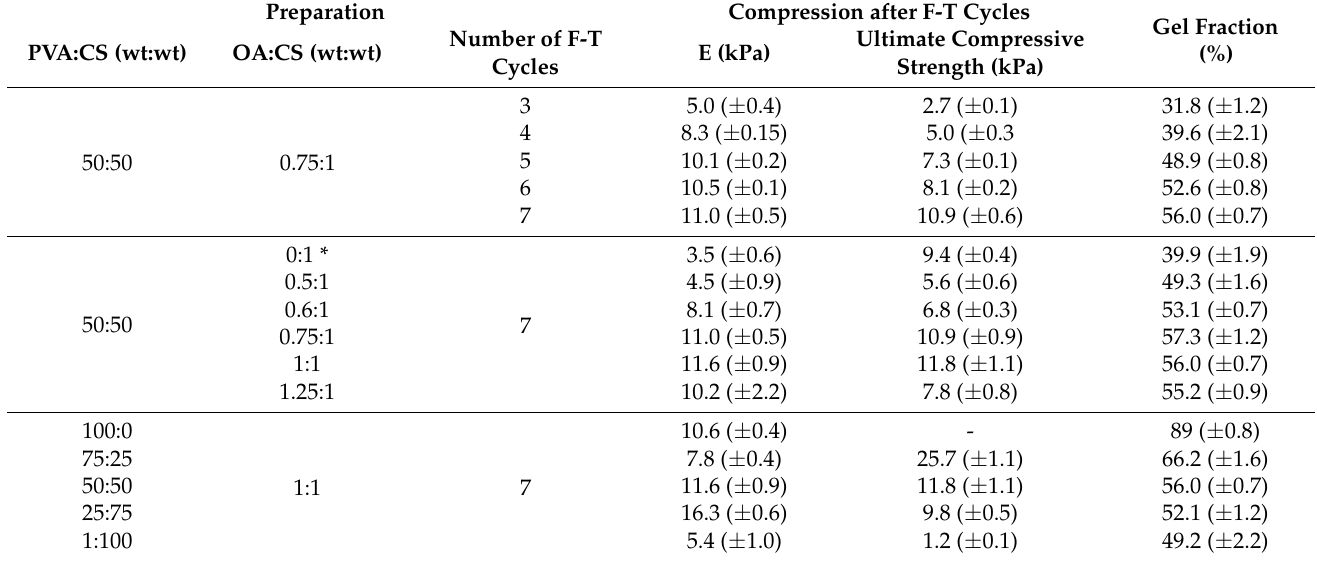
Table 1. Influence of the number of F-T cycles, OA:CS, and PVA:CS ratios on hydrogel characteristics.